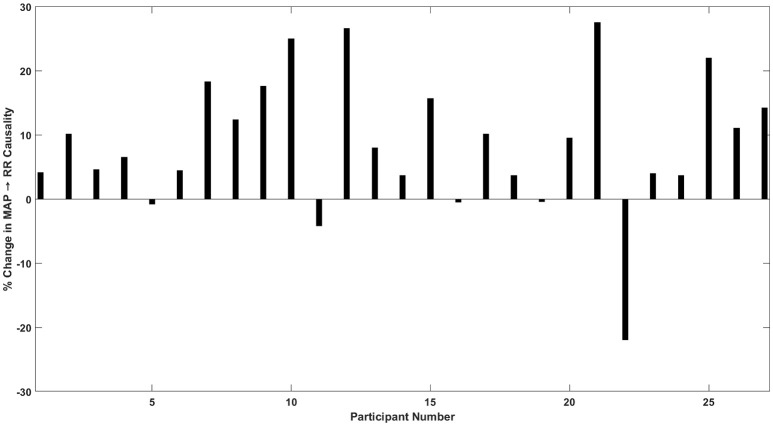
Percent (%) change in MAP→RR causality in response to −30 mmHg LBNP compared to rest. Out of 27 participants, 22 showed an increase, 2 participants showed a decline, and 3 participants did not show a change in MAP→RR causality at moderate LBNP compared to rest.